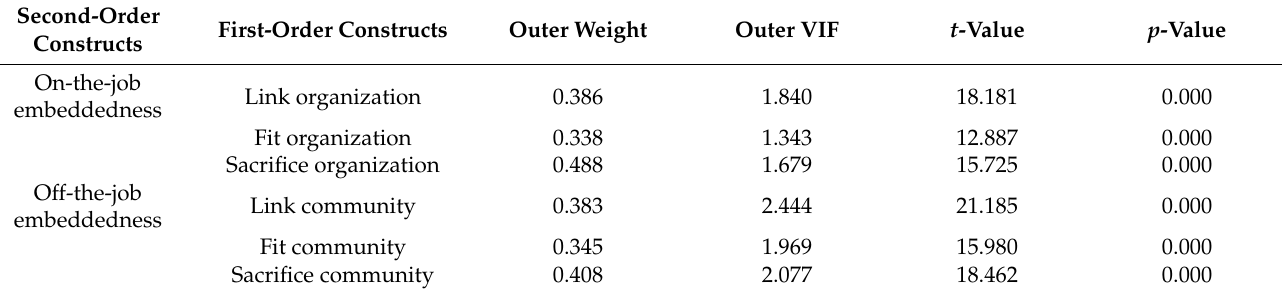
Table 3. Construct validity of formative